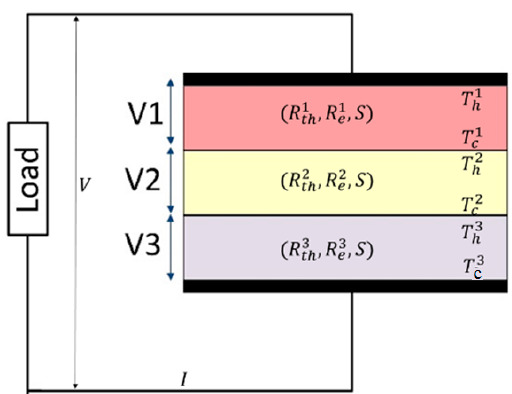
Figure 4. A schematic of the dividing thermoelectric generators (TEG) into stacked layers. Each block has a Seebeck coefficient, and an electrical and thermal resistance corresponding to its average temperature.